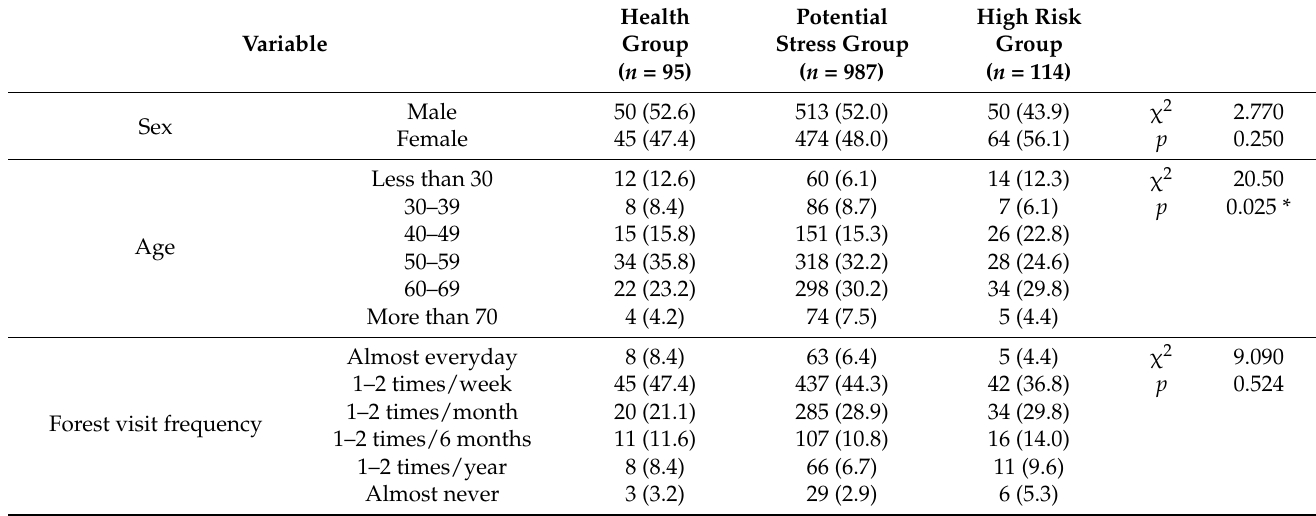
Table 5. Differences in social–psychological stress levels according to demographic characteristics.